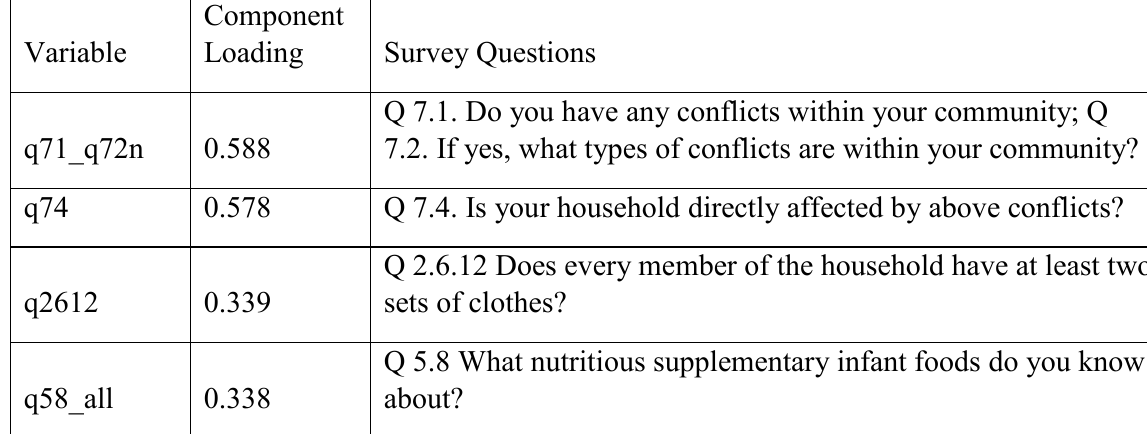
Table 1.14: Variables defining Absorptive Resilience PC7